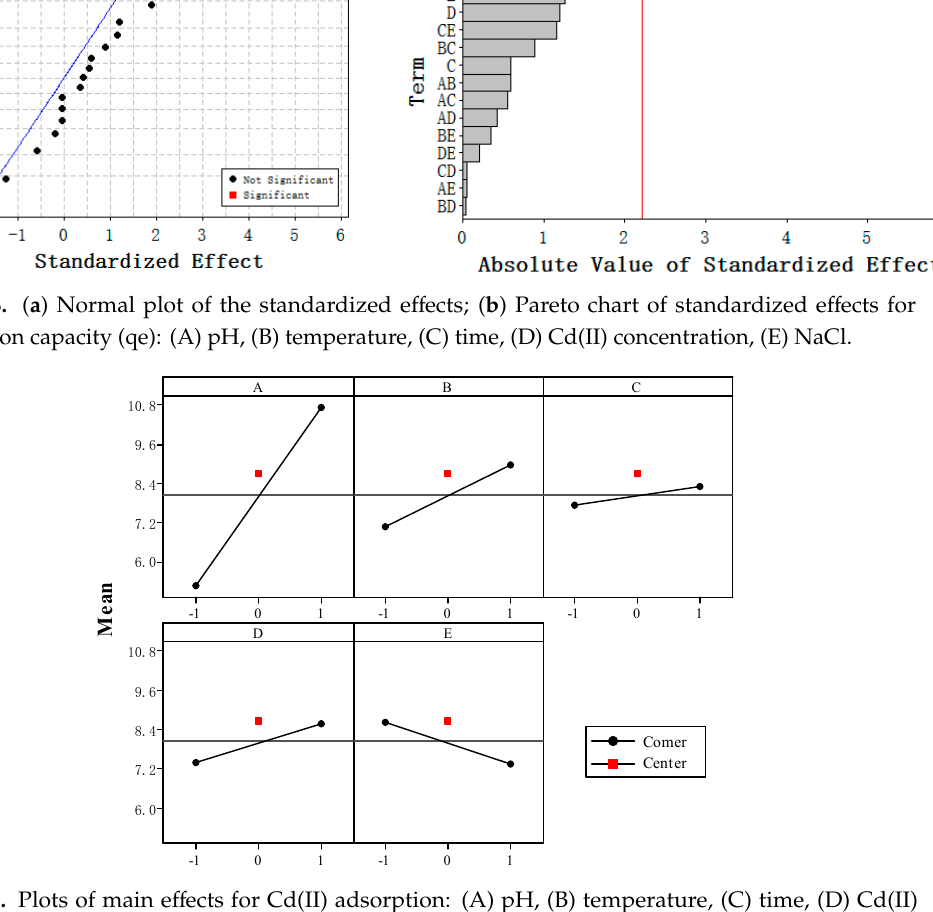
Figure 9. Plots of main effects for Cd(II) adsorption: (A) pH, (B) temperature, (C) time, (D) Cd(II) concentration, (E) NaCl. The symbols − 1 and 1 indicate the low and high levels of the factors, respectively.